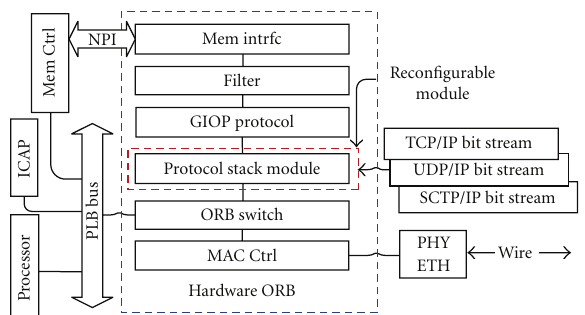
Figure 7: The general architecture of the hardware ORB IP core. the association between its local person’s features and the external person’s features kept by the CPT . The mechanism for the discovery of such a correspondence is based on the tracking algorithm explained in Section